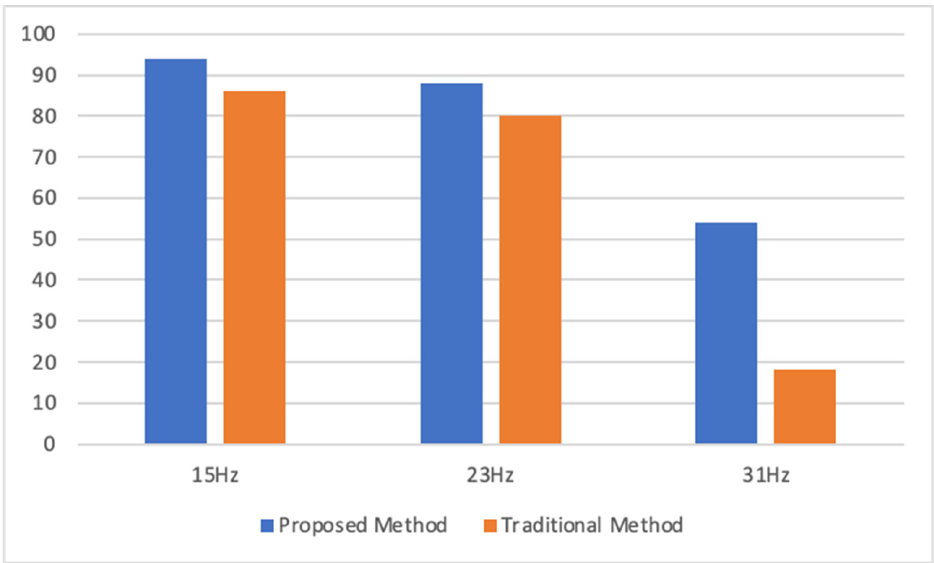
Figure 6. Graphical comparison of the accuracy rates of the proposed and traditional methods.